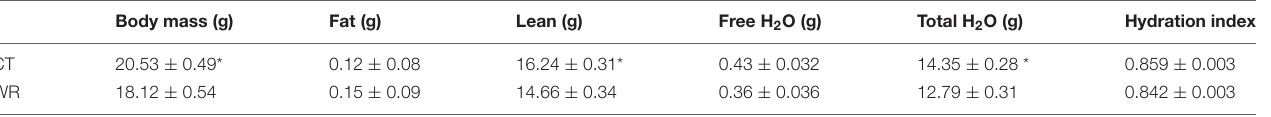
TABLE 2 | Mean ( ± SE) of body composition in Z. capensis acclimated to water restriction (WR) and control (CT) conditions for 15